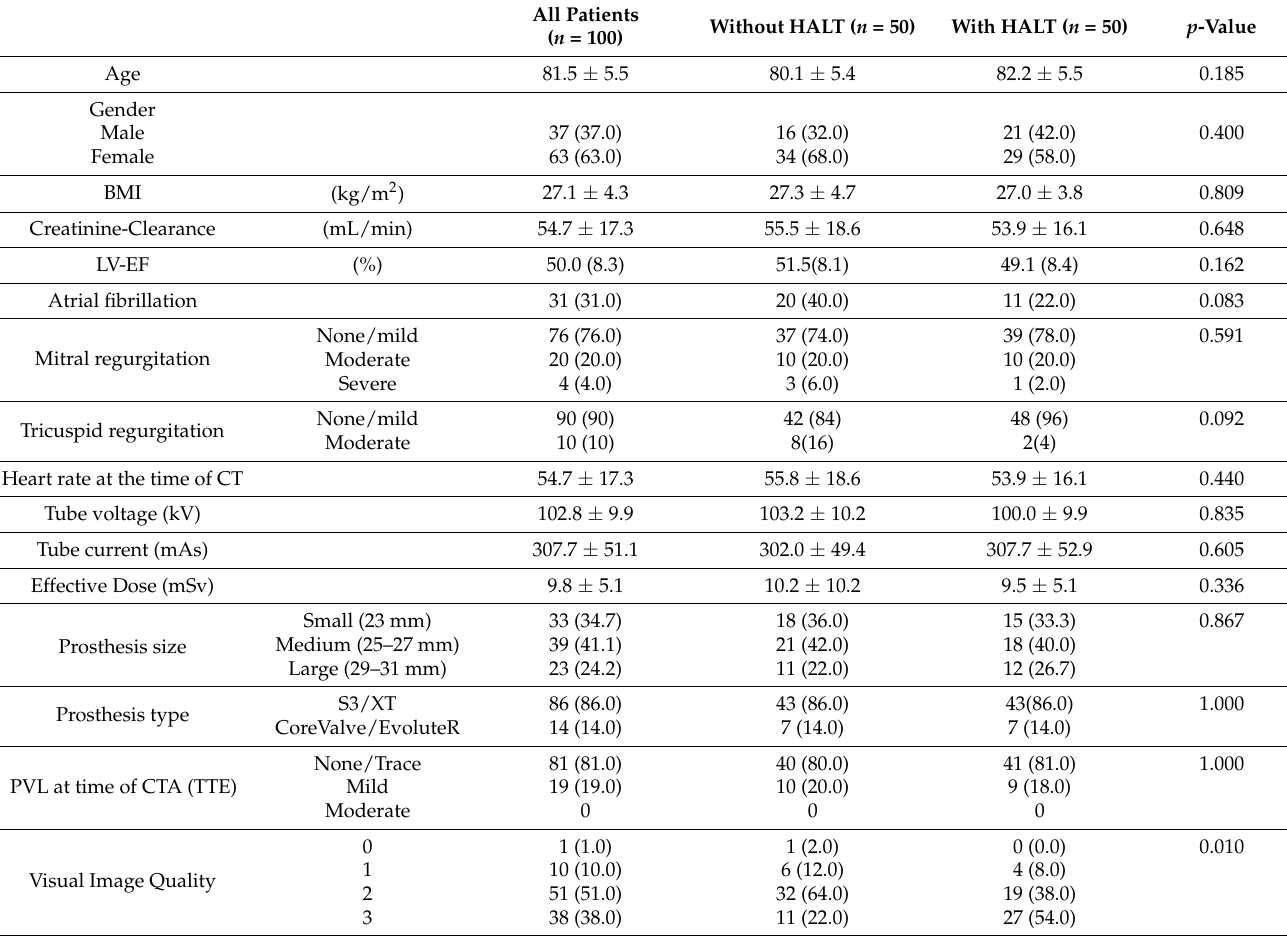
Table 1. Baseline characteristics of patients without and with